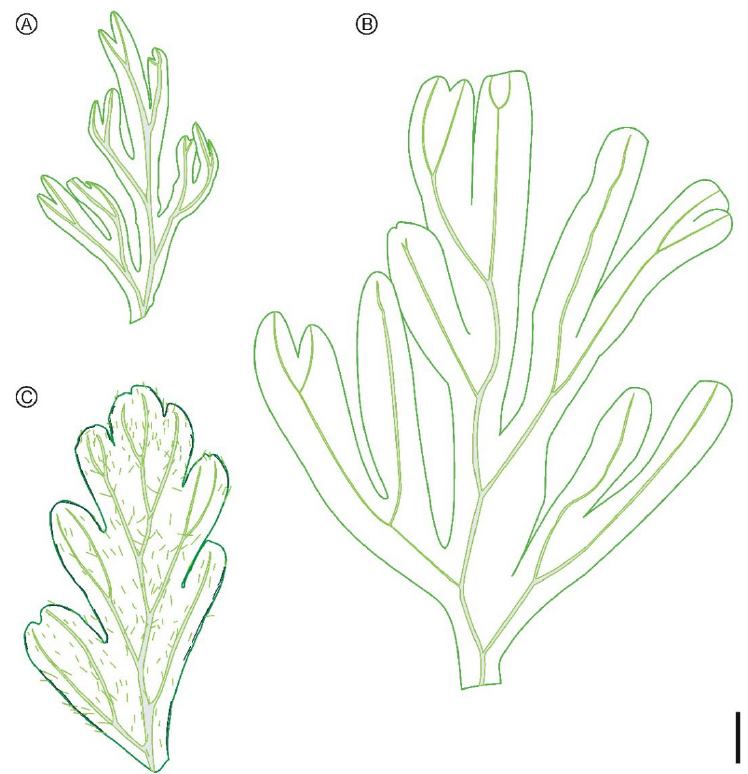
Figure 4. Schematic drawings of the pinnule of Hymenophyllites angustus sp. nov. ( A ), and the pinnae/pinnules of Hymenophyllites kachinensis sp. nov. ( B ) and Hymenophyllites setosus sp. nov. ( C ). Scale bar = 1 mm. Order: Selaginellales Prantl Family: Selaginellaceae Willk.